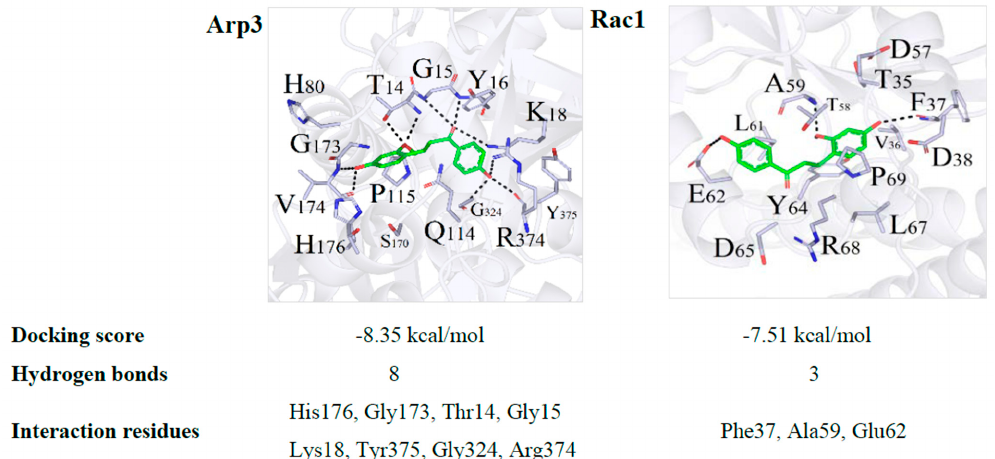
Figure 6. Interaction modes of LC with the binding pocket of Rac1 and Arp3. The black-dashed lines indicate hydrogen bonds with the residues in the binding cavity of proteins.